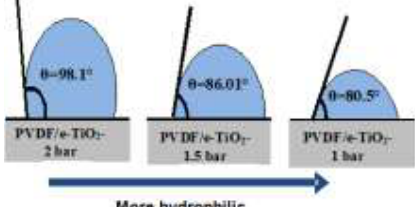
Figure 3: Contact angle of PVDF/e-TiO2-1 bar, PVDF/e-TiO2- 1.5 bar and PVDF/e-TiO2-2 bar